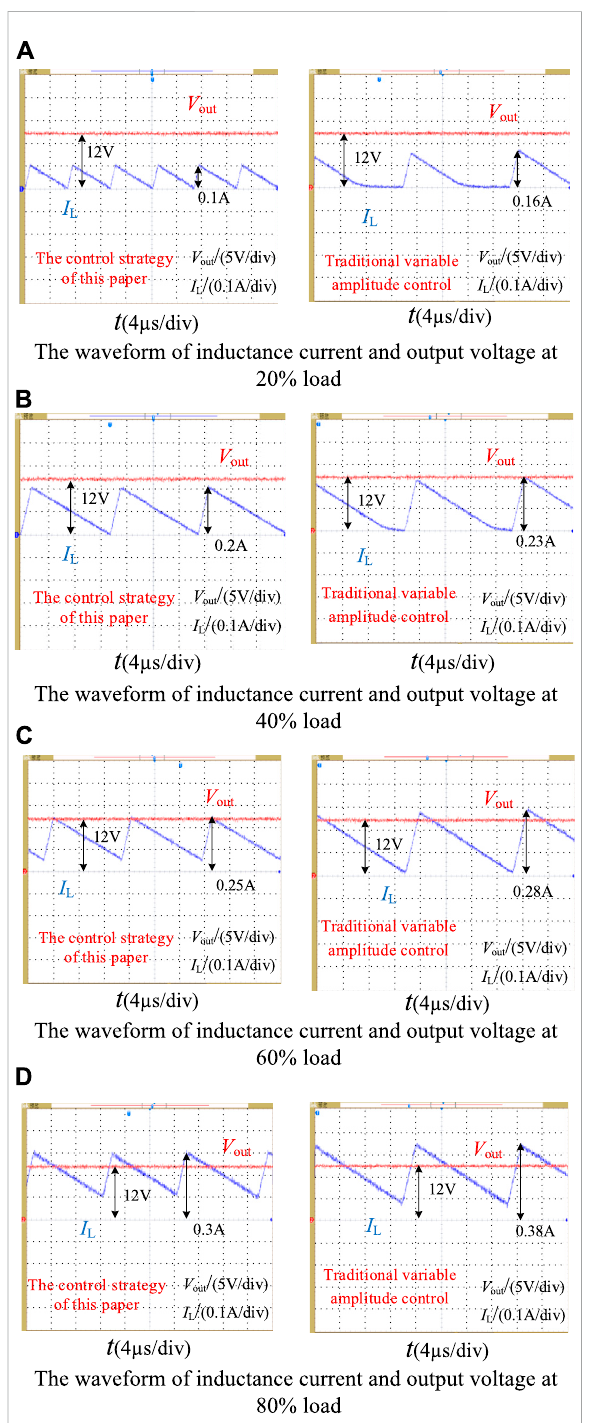
Waveforms under different loads at 100W rated